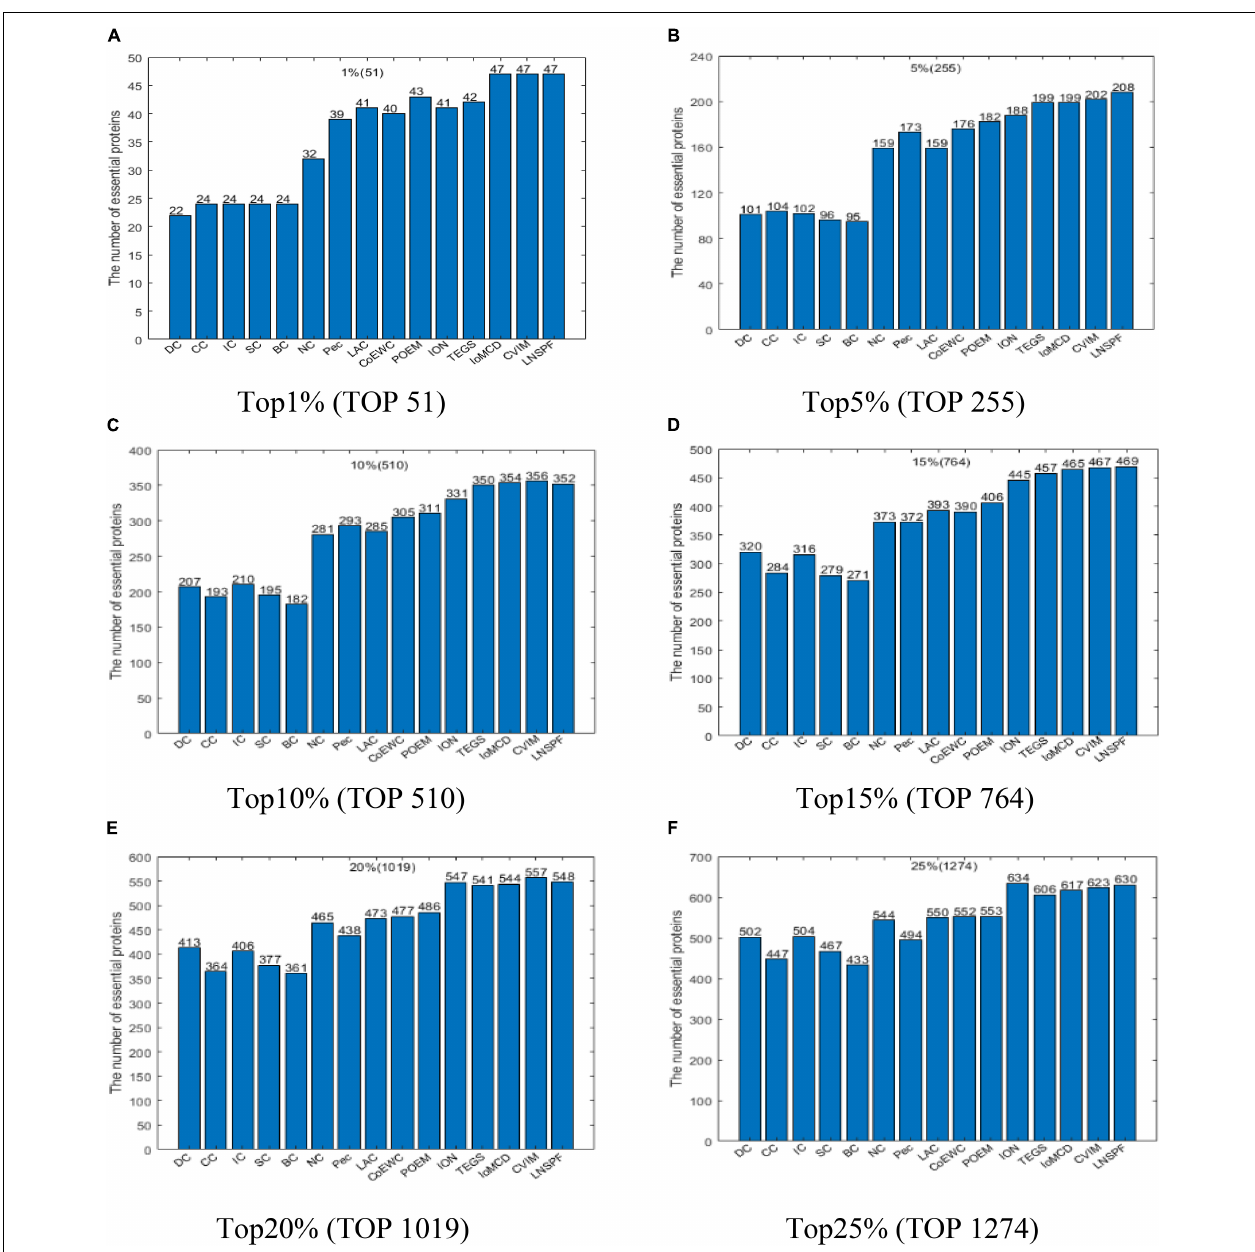
FIGURE 3 | Comparison results of the numbers of real key proteins predicted by LNSPF, DC, CC, IC, SC, BC, NC, PEC, LAC, CoEWC, POEM, ION, RWHN, IoMCD, and CVIM based on the DIP database. (A) Top 1% ranked proteins. (B) Top 5% ranked proteins. (C) Top 10% ranked proteins. (D) Top 15% ranked proteins. (E) Top 20% ranked proteins. (F) Top 25% ranked